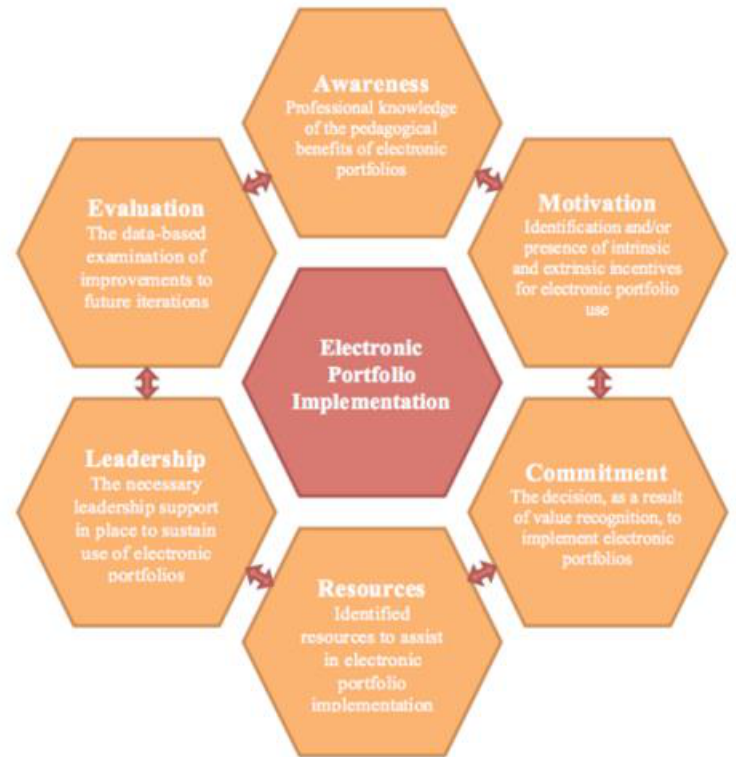
Figure 1. Blevins and Brill (2017) Eportfolio Implementation Framework, reproduced with